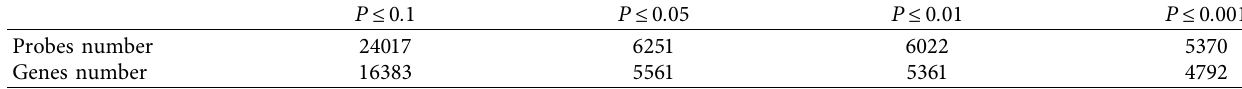
Table 1: Probes number and genes number under different P